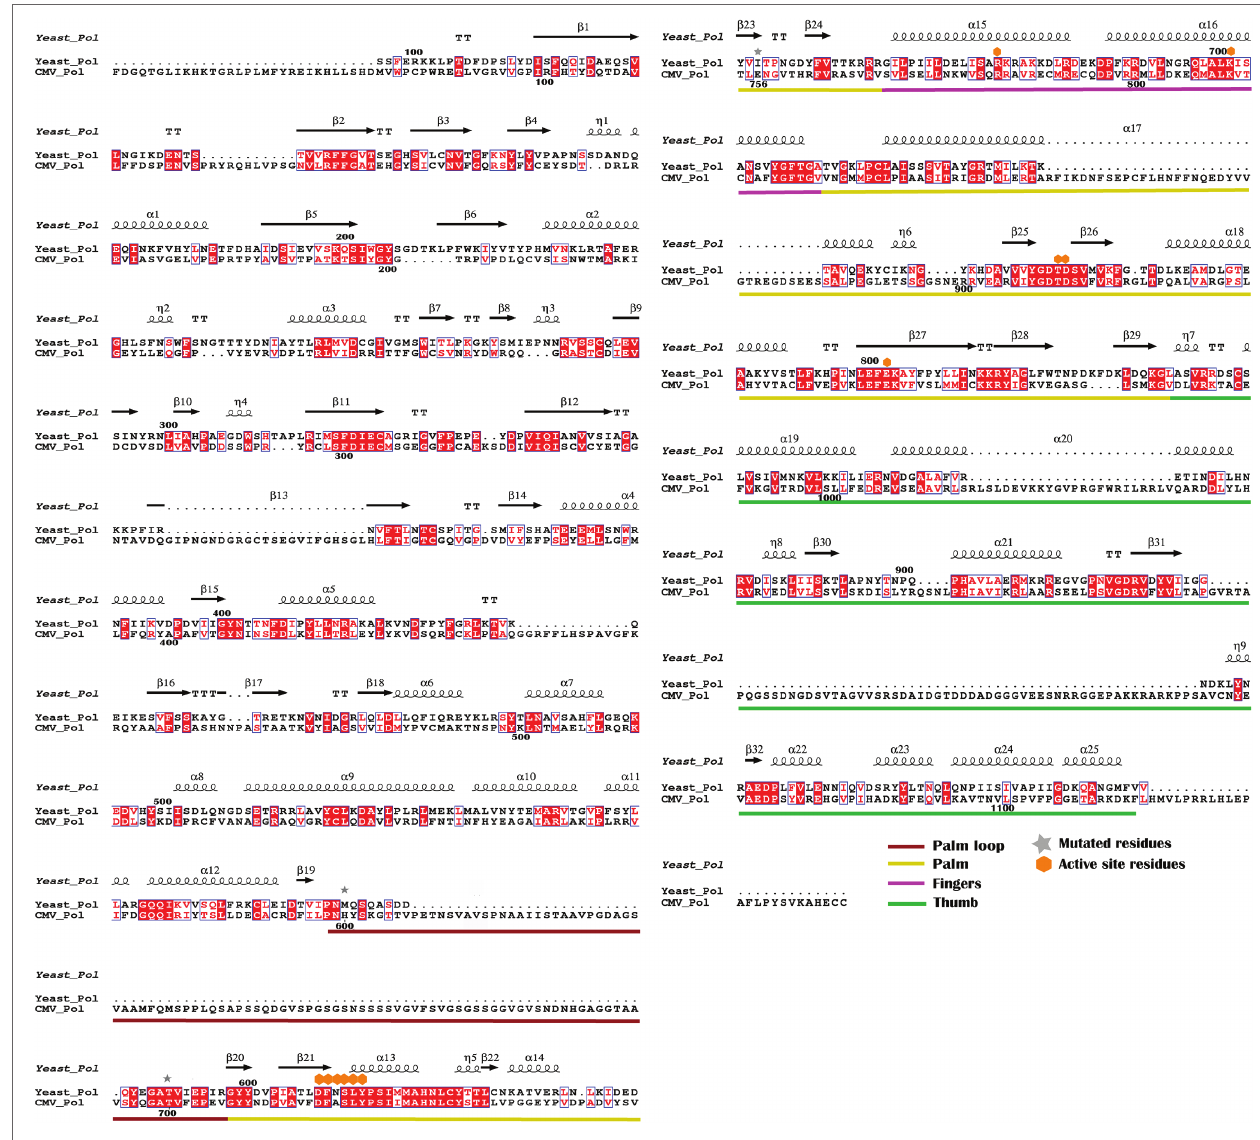
FIGURE 3 | Sequence alignment of yeast DNA polymerase δ with HCMV DNA polymerase UL54. The secondary structure of yeast DNA polymerase is displayed along with the amino acid sequence. Identical residues are highlighted in red. Brick, yellow, pink, and green bars cover regions for the palm loop, palm, thumb, and finger domains, respectively. Mutant and active site resides are also indicated by star and diamond symbols,